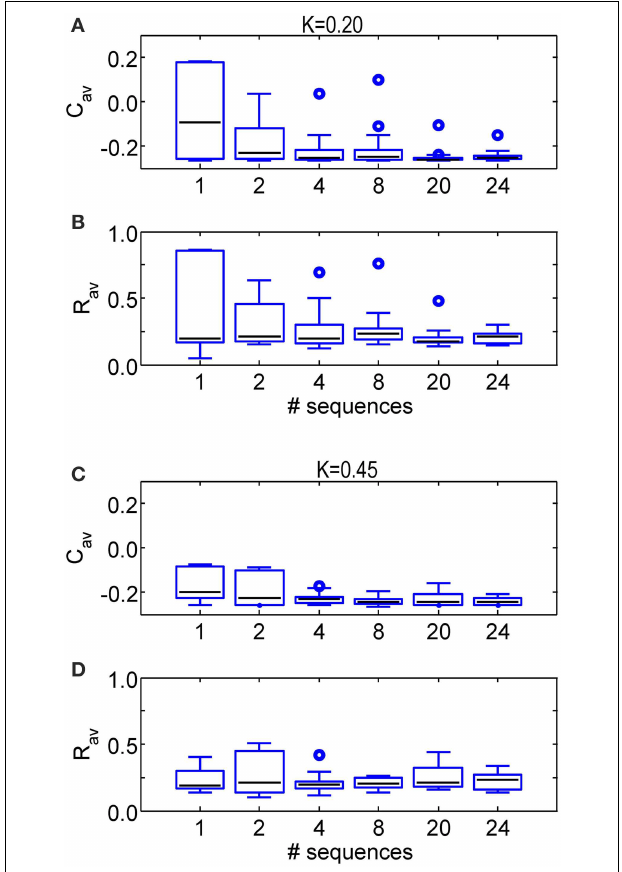
FIGURE 7 | Comparison of the anti-kindling effects for some numbers of different sequences applied during the SVS CR stimulation. (A) Boxplots of C av at t = 128 s for different numbers of sequence changes used in the SVS CR stimulation with K = 0 .20. (B) Boxplots of R av at t = 128 s for some numbers of different sequences used in the SVS CR stimulation with K = 0 .20. (C) As in (A) for K = 0 . 45 . (D) As in (B) for K = 0 . 45 . The black lines within the boxes show the medians for each condition, the boxes the middle 50% and the whiskers below (above) the boxes the first (last, respectively) 25%. Outliers are defined as 1.5 times the length of the box below or above the box and represented by open circles. For each condition ( K -value and number of sequences) the simulations are repeated eleven times for different initial conditions of the network in combination with different sequence(s). The number of consecutive sequence repetitions was adjusted with respect to the number of different sequences so that the duration of the CR-on period is always 64s for each simulation. For example if two different sequences are used, each of them is repeated 1200 times in a row, in case four different sequences are used, each of them is repeated 600